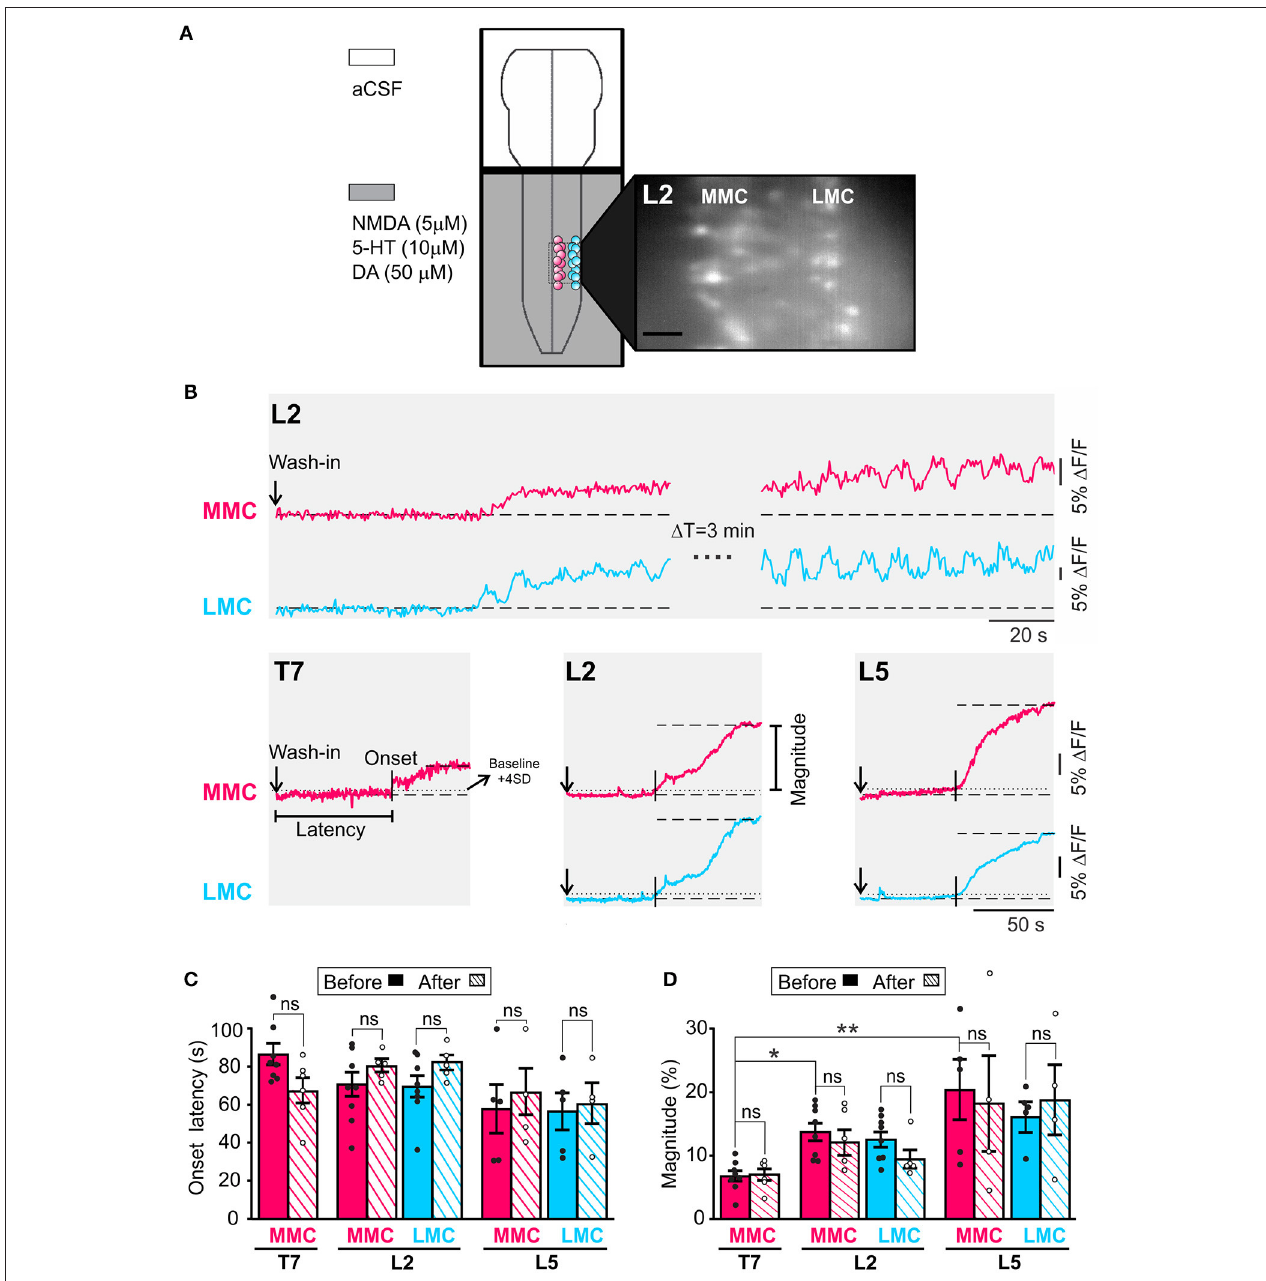
FIGURE 1 | An initial period of tonic activity accompanies rhythmic activity both in MMC and in LMC MNs. (A) Schematic representation of the experimental arrangement. The recording chamber was partitioned in two compartments with a plastic bridge sealed with petroleum jelly. The brain stem compartment (top) was superfused with aCSF while the spinal cord compartment (bottom) was superfused with aCSF plus NMDA (5 µ M), 5HT (10 µ M), and DA (50 µ M). The presence of the neurochemicals is indicated by the gray shading. MNs in the MMC (red circles) and LMC (blue circles) were loaded with fluorescent calcium indicator CaGDA (see Methods). Inset: Photomicrograph of CaGDA loaded MMC and LMC MNs in L2. Scale bar is 25 µ m. (B) Top: Changes in fluorescence following the arrival of the neurochemicals to the spinal cord compartment in a single MMC MN (red waveform) and LMC MN (blue waveform). The recording bouts on the left show the slow building up of the tonic component of LLA in each MNs. The recording bouts on the right, which were acquired 3min later, show the same tonic component as it reaches maximal magnitude (plateau). Bottom: Population responses (large ROI covering the entirety of the motor columns) showing the tonic component of LLA in MMC MNs of T7, L2, and L5 segments and LMC MNs of L2 and L5 segment. Vertical arrows: Time of application of neurochemicals. Vertical bars: Onset latency. Horizontal dashed line: Mean baseline fluorescence. Horizontal dotted line: Mean baseline fluorescence + 4 SD. (C) Bar graph showing the mean onset latency of the tonic component in T7, L2, and L5 MNs before (solid bars) and after (hatched bars) removal of the brain stem. Each bar is a grand average across all experiments (individual points). Mean onset latencies of tonic activity were similar before and after removal of the brain stem (Wilcoxon matched-pairs test, T7 MMC before